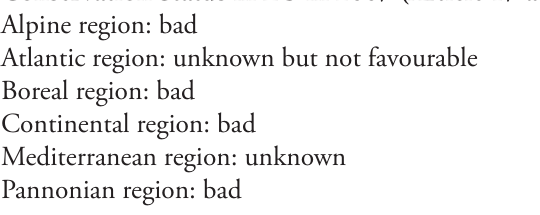
Red List Status Europe: Endangered EU: Endangered Conservation Status in EU in 2007 (Article 17 assessment) Alpine region: bad Atlantic region: unknown but not favourable Boreal region: bad Continental region: bad Mediterranean region: unknown Pannonian region: bad Threats in